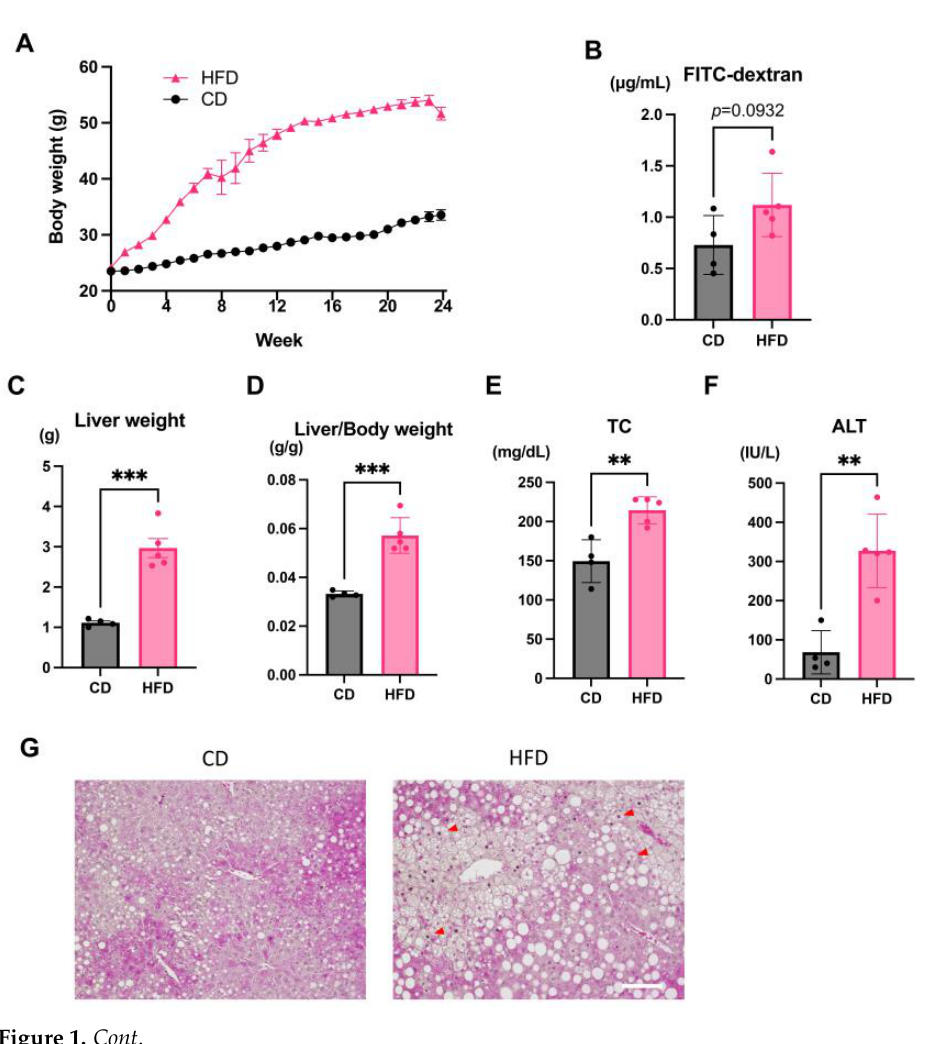
Figure 1. Mouse model of high-fat diet (HFD) induced nonalcoholic fatty liver. ( A ) Body weight gain of HFD- and control diet (CD)-fed mice. ( B ) The concentration of blood fluorescein isothiocya- nate (FITC)-dextran following oral administration to mice. ( C – F ) Liver weight, Liver/body weight ratio, serum total cholesterol (TC), and serum aspartate aminotransferase (ALT) of the HFD and CD groups. ( G ) Hematoxylin and eosin (H&E) staining of livers from HFD- and CD-fed mice. Scale bar: 100 μm. Red Arrowheads show ballooning cells. ( H ) The non-alcoholic fatty liver disease activity score (NAS) is the sum of the lobular inflammation, ballooning, and steatosis scores according to the H&E score. ( I ) Area of liver steatosis of HFD- and CD-fed mice. All data represent the mean ± standard error of the mean. Student ’ s t -test, ** p < 0.01, *** p < 0.001, **** p < 0.0001. n = 4, CD group; n = 5 HFD group. H&E staining of the liver showed hepatic steatosis and mild hepatocyte ballooning degeneration in HFD-fed mice and a significant increase in NAFLD activity score (Figure 1G – I). The upper small intestine and lower small intestine showed no obvious differences in H&E staining (Figure 2AB ) . Fluorescence immunostaining showed that the localization of Zo-1 on the plasma membrane of IECs in the upper small intestine was decreased in the HFD group, suggesting TJ dysfunction (Figure 3).